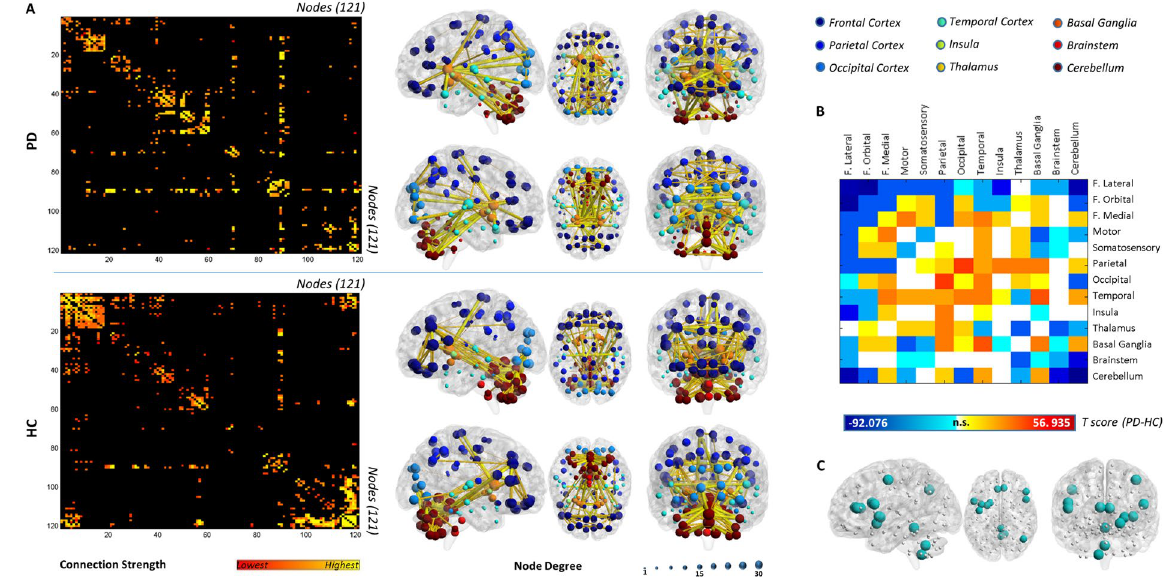
Figure 1. Whole-brain analysis. ( A ) Figure shows the whole-brain connectivity matrices of PD and HC (first column), with the red-yellow colour gradient representing the strength of the correlation between two nodes. The second column shows PD and HC connectomes projected on a 3D brain template. A global connectivity reconfiguration is present, with frontal and cerebellar regions being the most affected in PD patients. Node degree, i.e. the number of connections for each region, is represented by the size of each dot. Connection strength is represented by the colour and thickness of each line connecting two nodes. ( B ) The T-score matrix shows differences in the number of connections within and between each sub-matrix in PD versus HC. Abbreviations: F: Frontal. ( C ) Figure shows lost hub regions, i.e. nodes that assume the role of hubs in HC but not in PD. Hub identification was based on participation coefficient. Hubs are represented on a 3D brain template using BrainNet